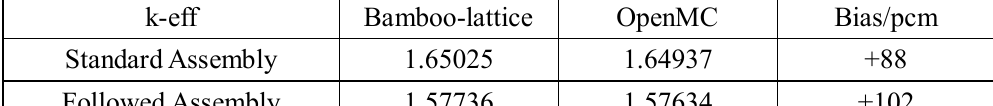
Table II. Comparison of k-eff of fresh fuel assemblies